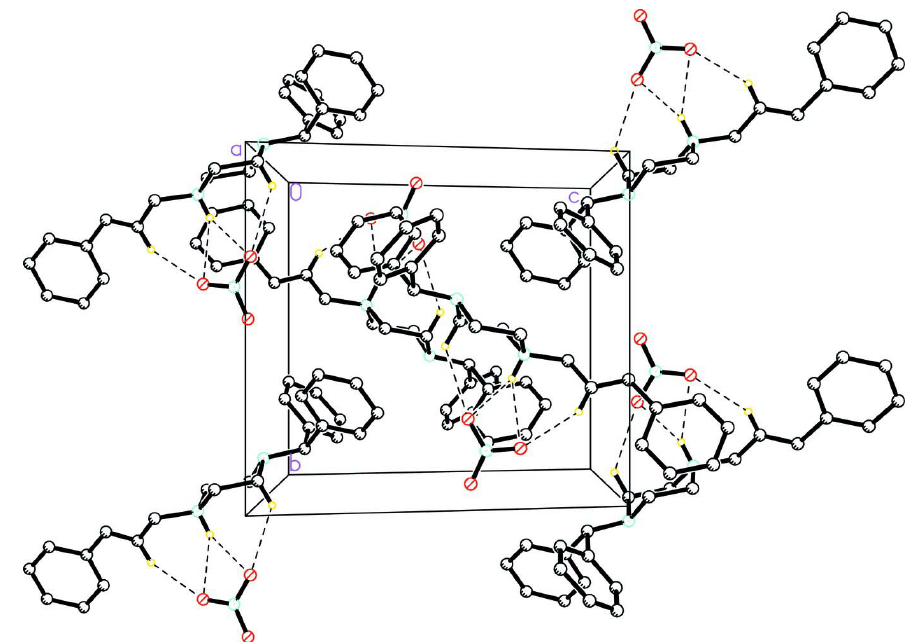
The crystal packing of the title compound viewed along the a axis. Hydrogen atoms not involved in hydrogen bonding (dashed lines) are omitted for